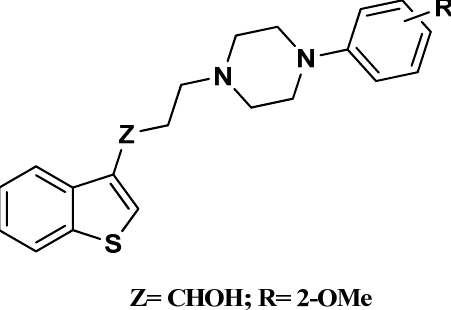
Figure 1. General structure of benzothiophene hydroxylpropylarylpiperazine